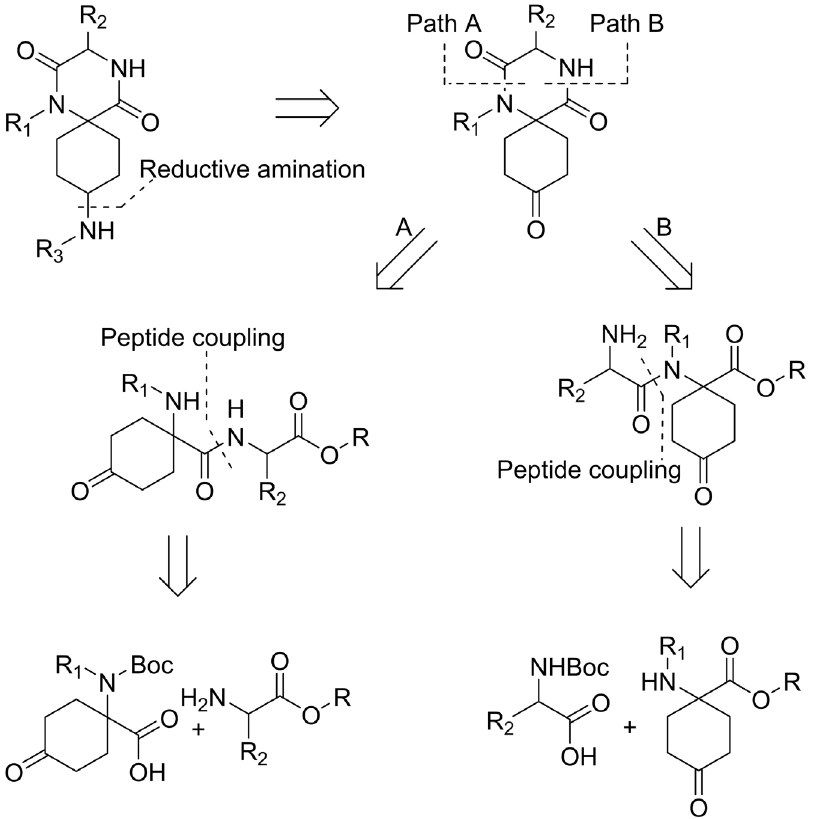
Fig 3. Retrosynthetic analysis of